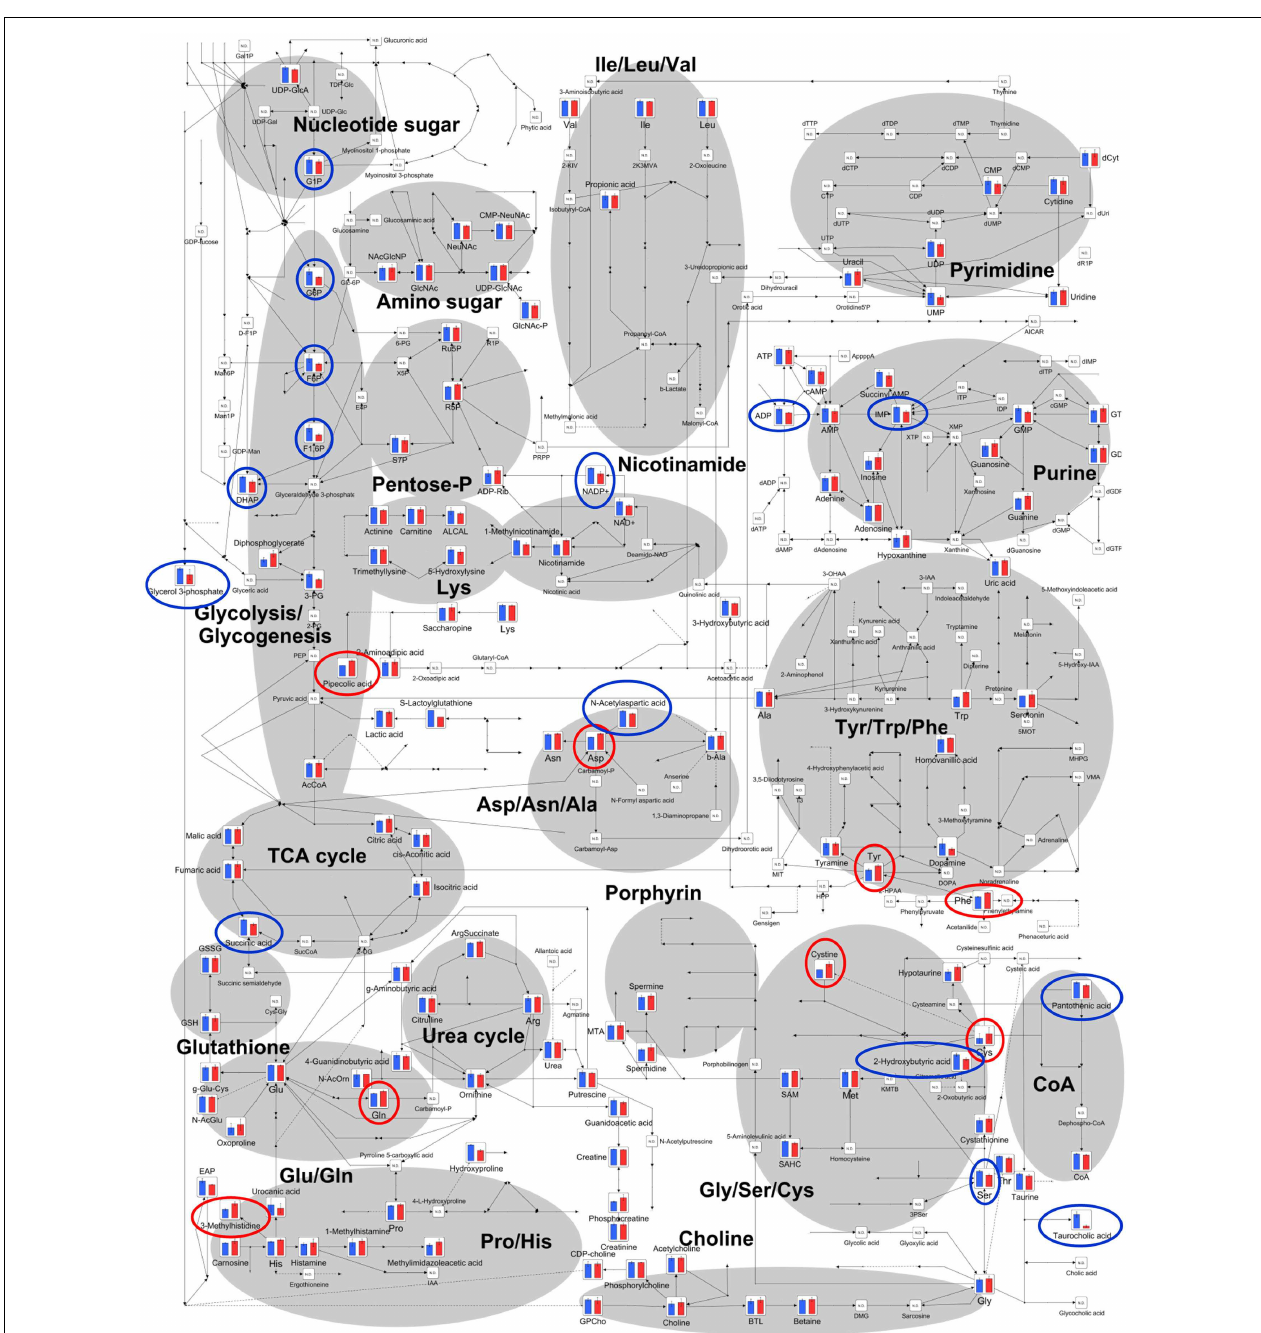
Ex-GF). Metabolites surrounded by blue and red circles are of higher and lower concentrations, respectively, in GF mice than Ex-GF mice. ND, not